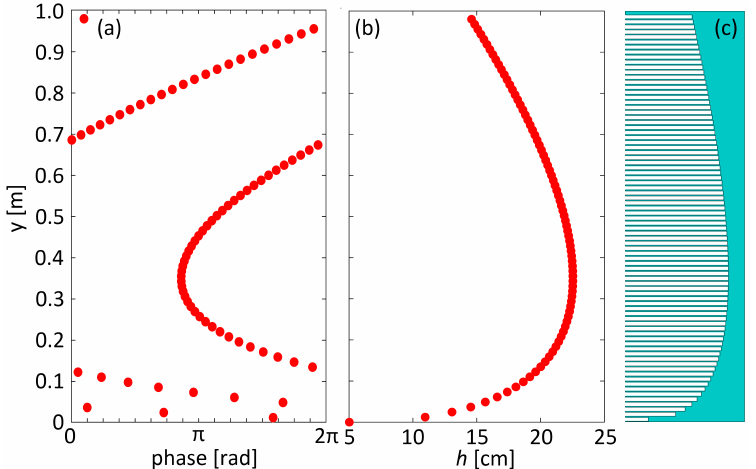
Figure 3. Desired parameters for the generation of bending beams. ( a ) The phase profile at the interface of the structure for the bending beam with R = 0.35 m, and ( b ) the corresponding depth profile for the bending beam (see Equation (2)). ( c ) The metastructure is designed based on the depth profile in ( b ).